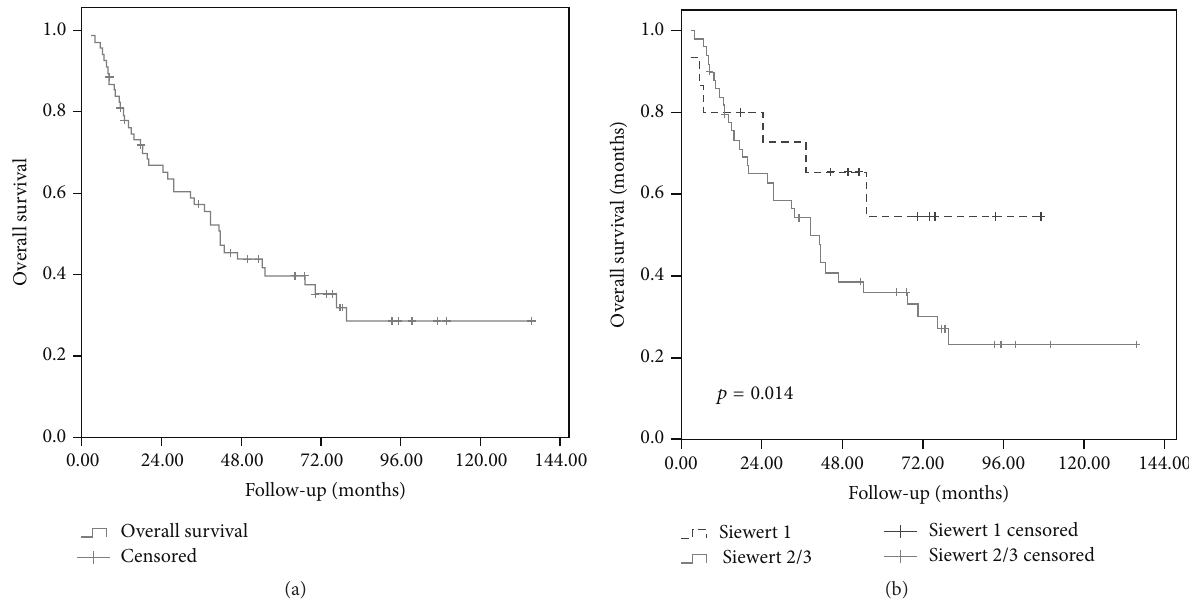
Figure 1: Overall survival for overall population (a) and according to the Siewert classification